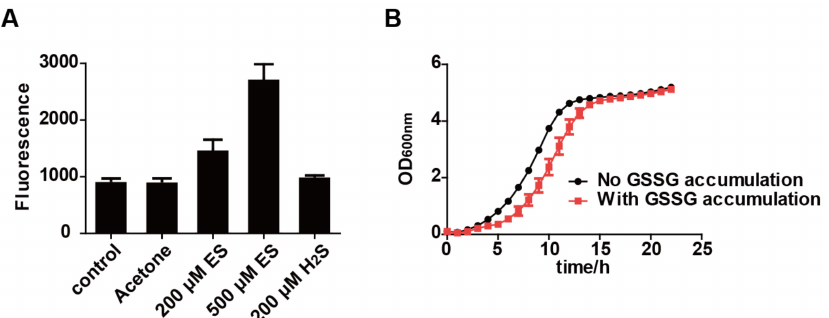
Figure 5. The accumulation of GSSG caused oxidative stress and inhibited cell growth. ( A ) Intra- cellular ROS of S. cerevisiae resting cells with or without GSSG accumulation. The resting cells of S. cerevisiae were set at OD 600nm = 2.0. ( B ) The growth of S. cerevisiae with or without GSSG accumu- lation. The initial OD 600nm was adjusted to 0.05. Data are averages of three parallel experiments with standard deviations. ES, elemental sulfur.